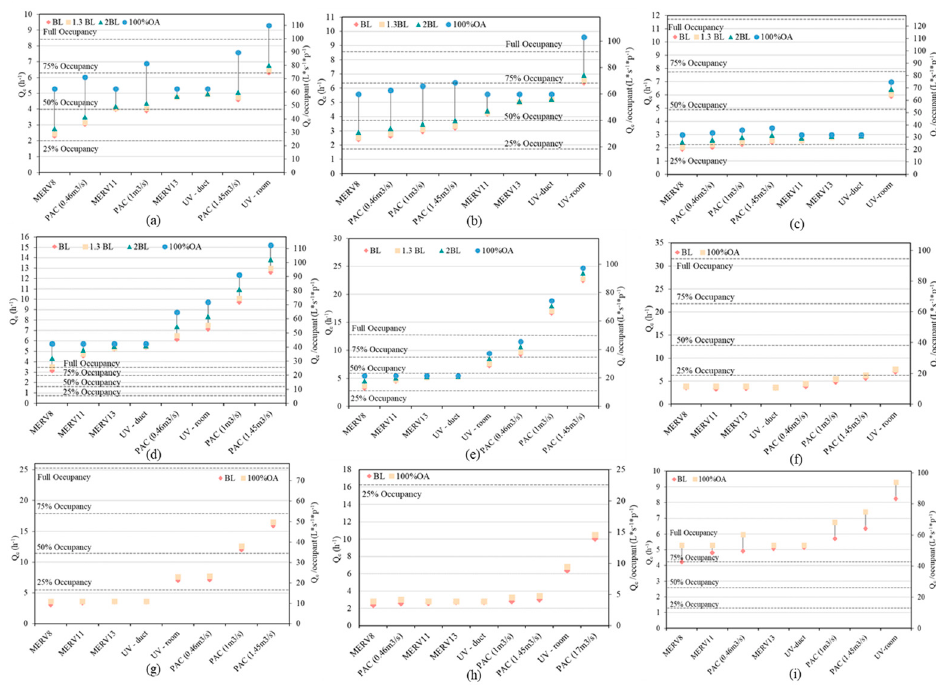
Figure 17. Minimum Q e for different mitigations without mark-wearing: ( a ) Medium Office—Core zone, ( b ) Large Office—Core zone, ( c ) Stand Alone Retail—Core Retail, ( d ) Small Hotel—Front Lounge, ( e ) Small Hotel—Meeting Room, ( f ) Secondary School—Classroom, ( g ) Secondary School— Corner Classroom, ( h ) Secondary School—Auditorium, ( i ) Secondary School—Café.